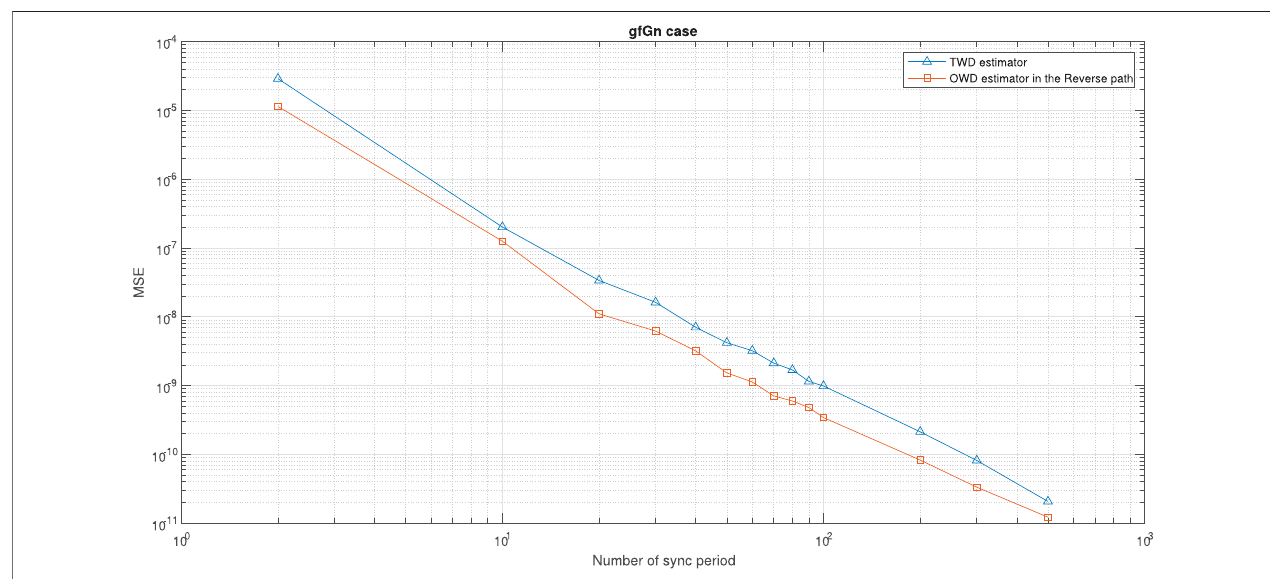
FIGURE 8 | Test case b of Theorem 8. Performance (MSE) comparison between the OWD clock skew estimator in the Reverse path ( Eq. 62 ) and the TWD clock skewestimator( Eq.60 ).ThePDVisangfGnprocess. α =50 ppm , Q =5 ms , T syn (cid:2) 15 . 6 ms ( 64 packet